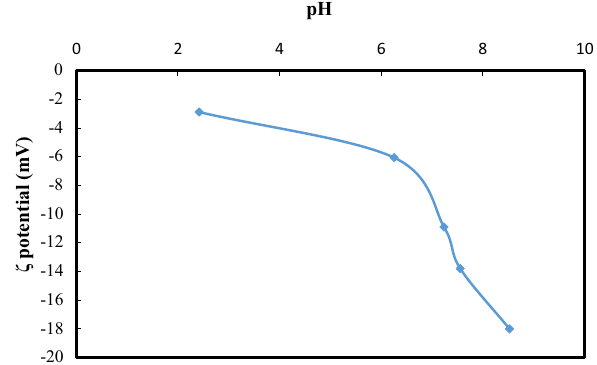
Fig. 3 Effect of pH on the heavy metal biosorption onto Posidonia oceanica